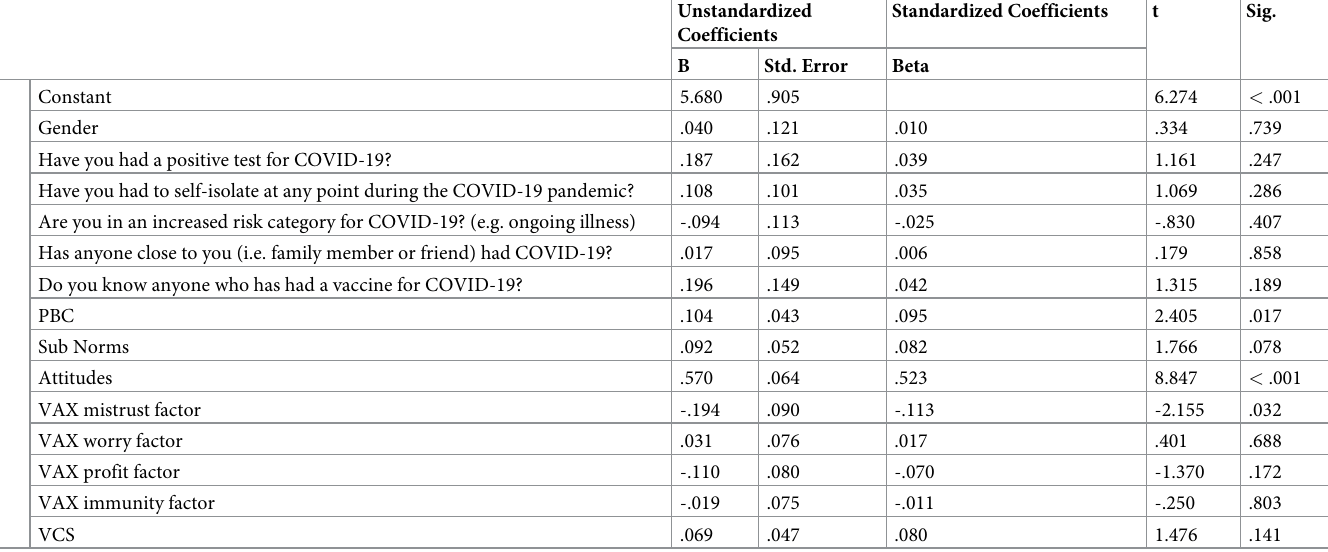
Table 5. Regression